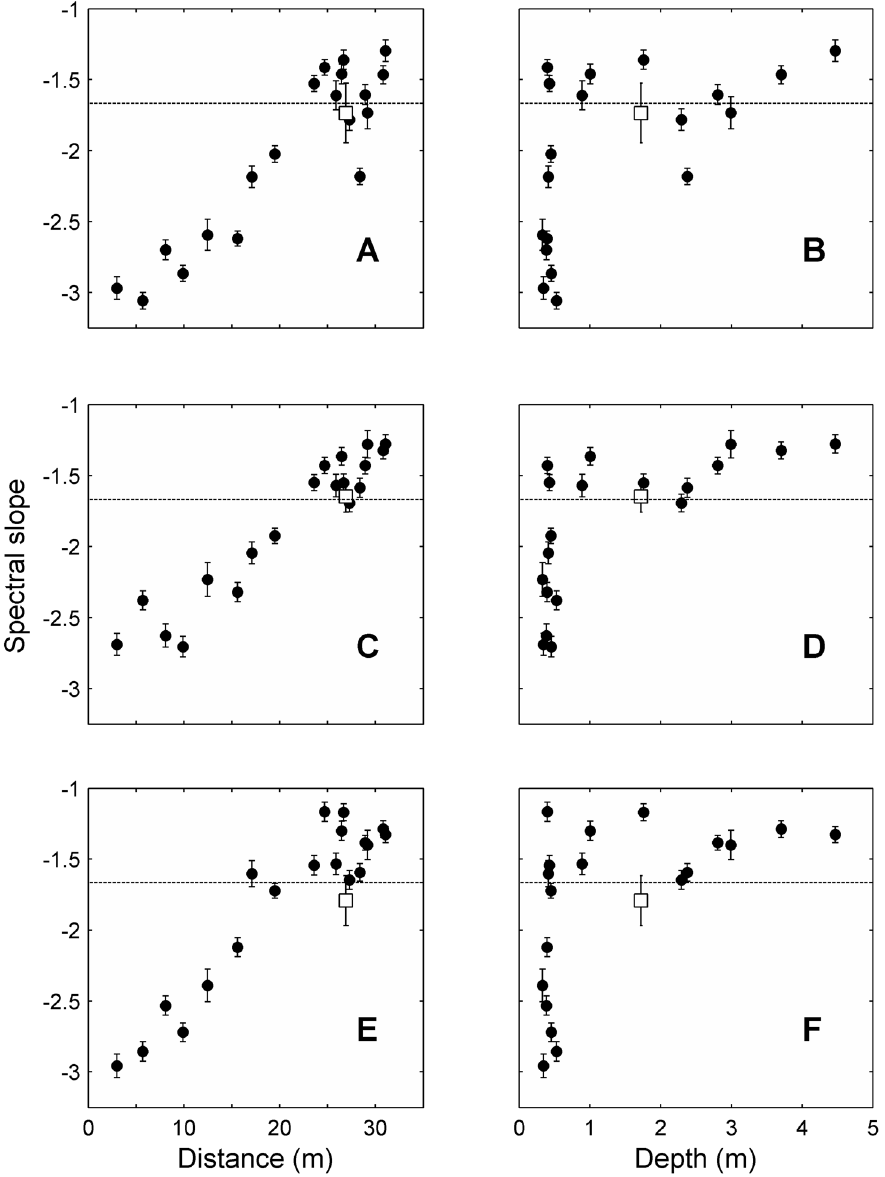
Figure 7. Spectral slopes vs. distance from shore and depth. Spectral slopes of temperature (A & B), dissolved O 2 (C & D) and pH (E & F) vs. distance from shore (left column) and depth (right column) of each station along the transect. Dots with error bars represent the fitted slopes with 95% confidence intervals. Empty squares with error bars show the mean 6 standard deviation of all the spectral slopes in the long-term station estimated for each period of deployment. Dashed horizontal lines mark the 2 5/3 typical of 3D isotropic turbulence spectra.